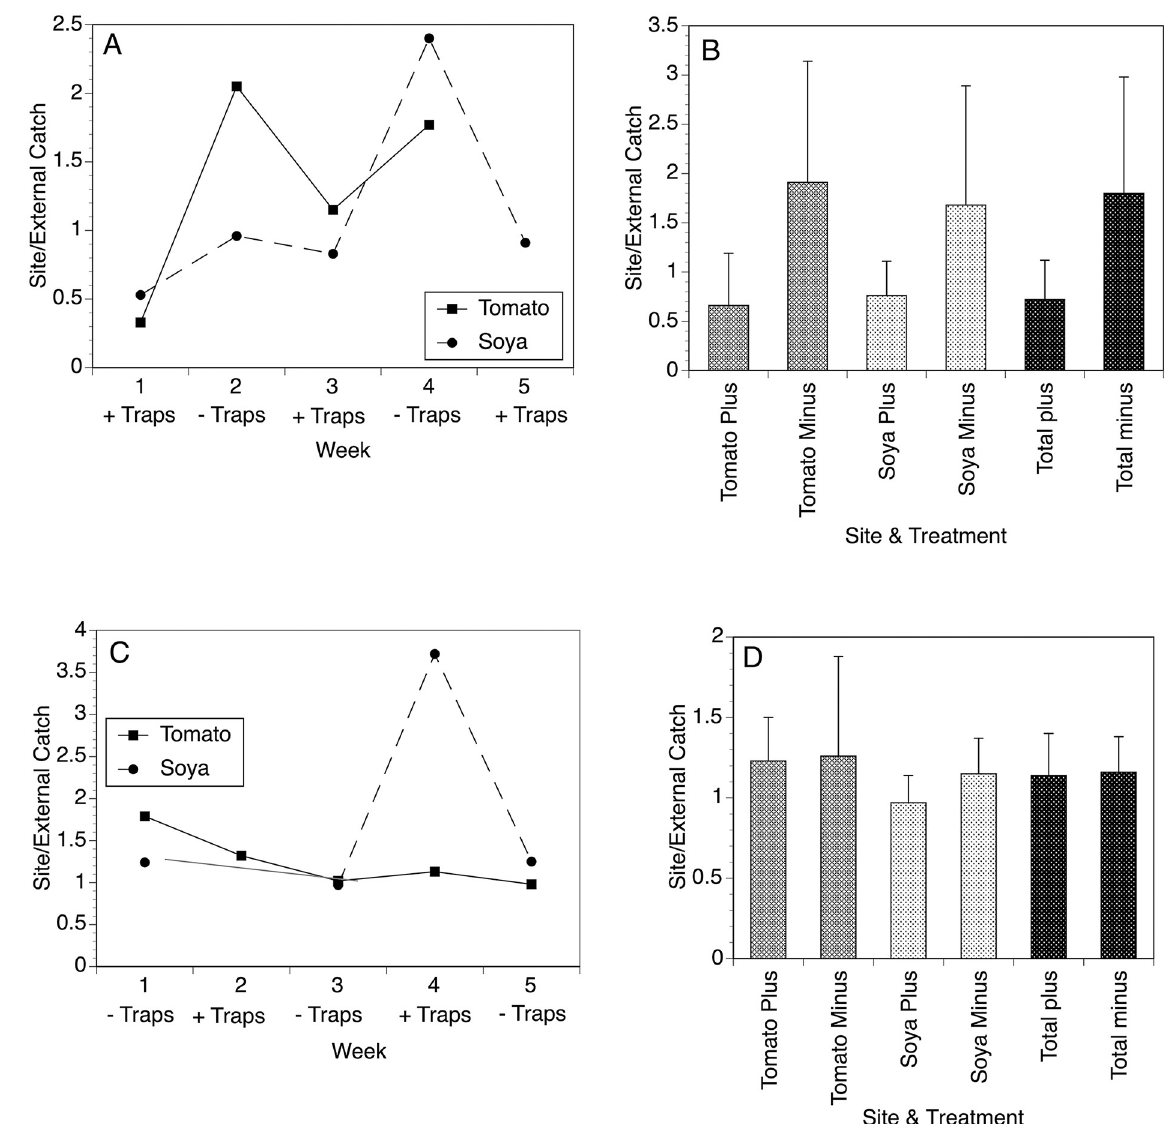
Fig 8. Effect of EWT trap deployment on biting rate in the fields of Gonycogo and Laminatoo. Panel A: Weekly fly collections in the tomato and soya fields of Gonycogo in the presence and absence of the traps. Traps were deployed and taken down in alternate weeks. Data are normalized to the number of flies collected by an external collector, to account for variations in the overall fly population. Panel B: Mean weekly collections in the tomato and soya fields of Gonycogo in the presence and absence of the traps. Error bars represent the standard deviations of the means. Panel C: Weekly fly collections in the tomato and soya fields of Laminatoo in the presence and absence of the traps. Traps were deployed and taken down in alternate weeks. Data are normalized to the number of flies collected by an external collector, to account for variations in the overall fly population. Panel D: Mean weekly collections in the tomato and soya fields of Laminatoo in the presence and absence of the traps. Error bars represent the standard deviations of the means. Raw collection data for this study may be found in the S6 Table.